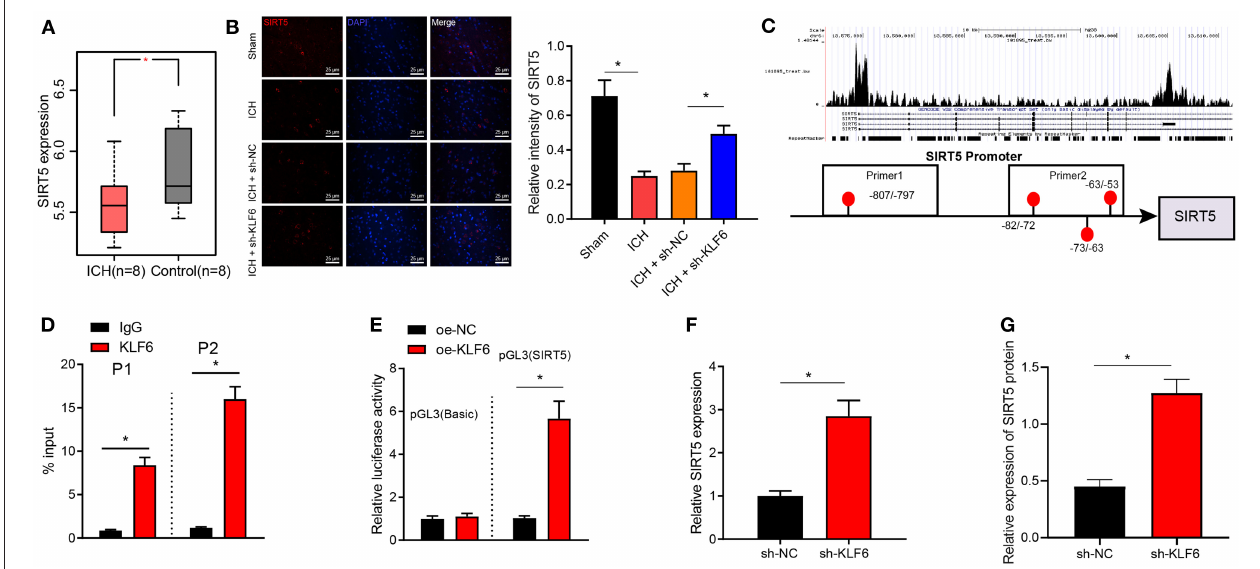
FIGURE 6 | KLF6 binds to SIRT5 promoter to inhibit its transcription. (A) The expression of SIRT5 in the ICH-related microarray GSE149317. The box diagram represents the expression of SIRT5 gene. (B) SIRT5 colocalization with hippocampal neurons in ICH rats detected by immunofluorescence staining. (C) The enrichment of KLF6 in the SIRT5 promoter region detected by CistromeDB database ChIP-Seq data, and the binding site of KLF6 and SIRT5 promoter predicted by JASPAR database. (D) The enrichment of KLF6 in SIRT5 promoter − 20/ − 220 (Prime2) and − 700/ − 900 (Prime1) regions determined by ChIP assay. (E) The effect of KLF6 overexpression on the luciferase activity of SIRT5 promoter determined by dual luciferase reporter gene assay. (F) The level of SIRT5 in hippocampal neurons infected with sh-KLF6 determined by RT-qPCR. (G) The level of SIRT5 in hippocampal neurons infected with sh-KLF6 determined by Western blot analysis. * p < 0.05. The measurement data were expressed as mean ± standard deviation. Comparisons between two groups were analyzed using unpaired t -test, and comparisons among multiple groups were tested by one-way ANOVA followed by Dunnett post-hoc test. The experiment was repeated three times.